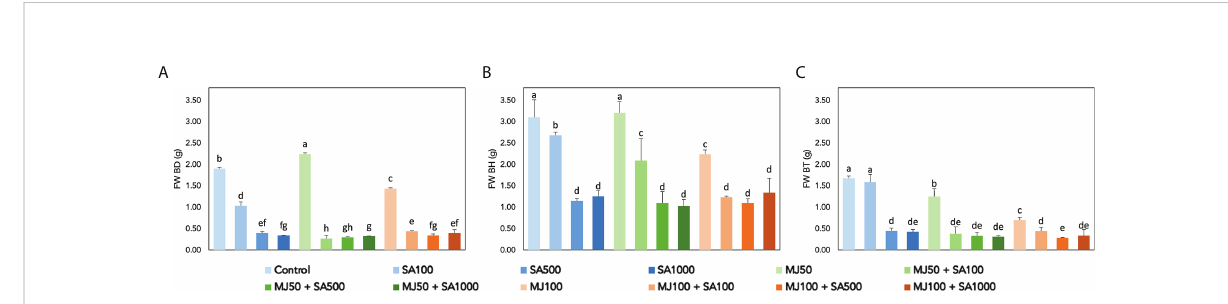
FIGURE 3 Fresh biomass determination of elicited Bryophyllum PCSCs, expressed as grams of fresh weight (FW) for (A) BD, (B) BH, and (C) BT. Vertical bars indicate standard deviation. Different letters indicate signi fi cant differences between elicitor treatments according to Duncan ’ s post hoc test ( p<